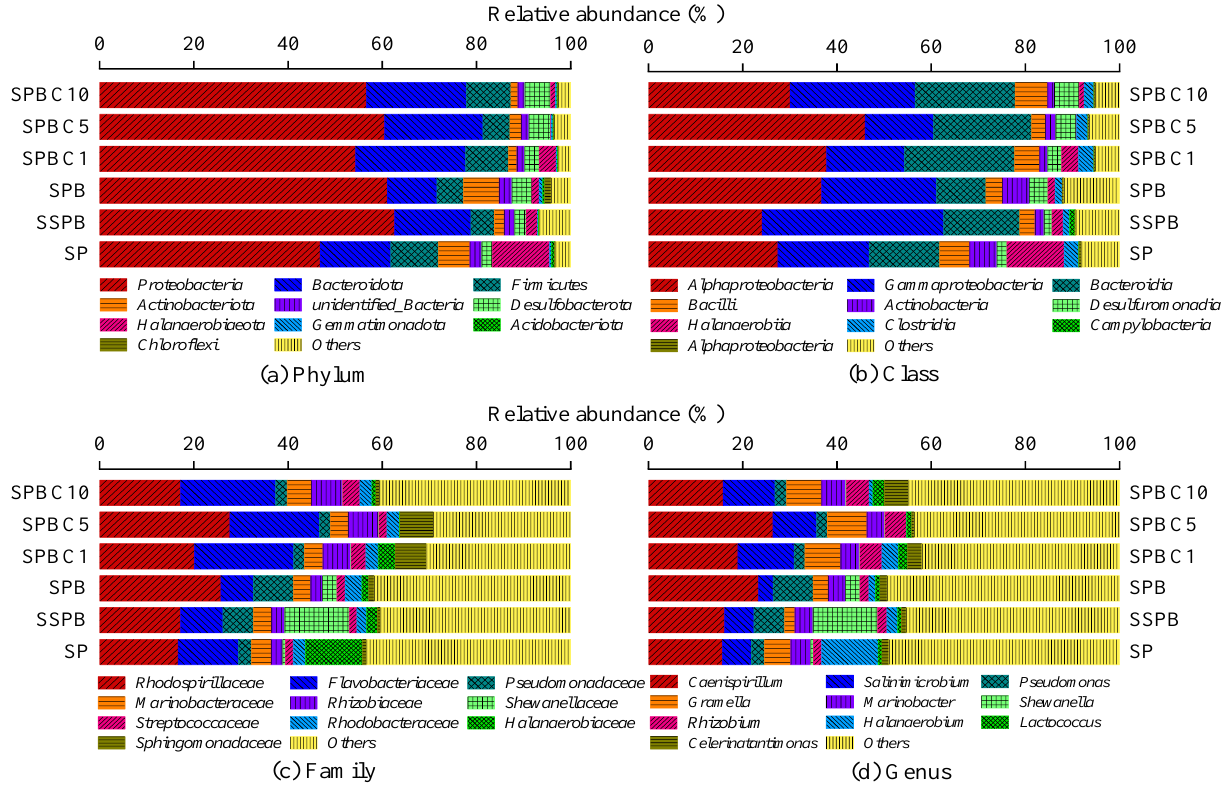
Figure 2. Top 10 microbial community composition distribution at ( a ) phylum, ( b ) class, ( c ) family, and ( d ) genus level. Notes: “S” represents “unsterilized soil”, “SS” represents “sterilized soil”, “P” represents “plant”, “B” represents “functional bacteria”, “C” represents “biochar”, and the number following the abbreviation represents the proportion of biochar mass to soil mass. Table 2. The relative abundance of the added FB at genus level.